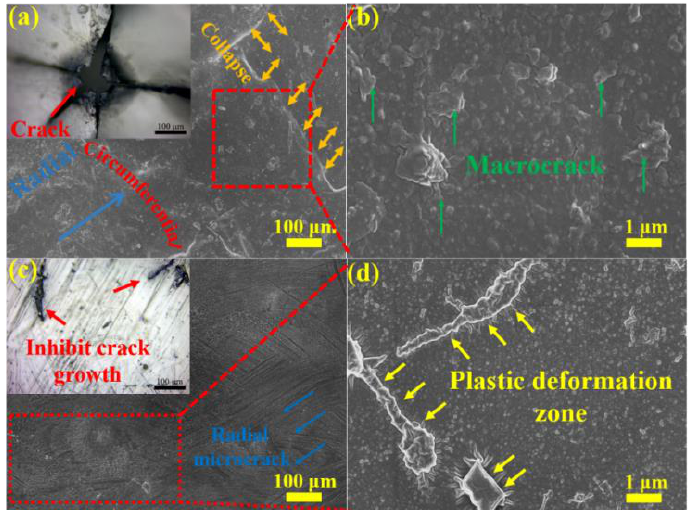
Figure 7. ( a , c ) Optical and SEM microscopes images of ( a ) pure PUE and ( c ) A-WS 2 @MWCNTs/PUE surface, and ( b , d ) SEM images corresponding to the selected area in ( a , c ).